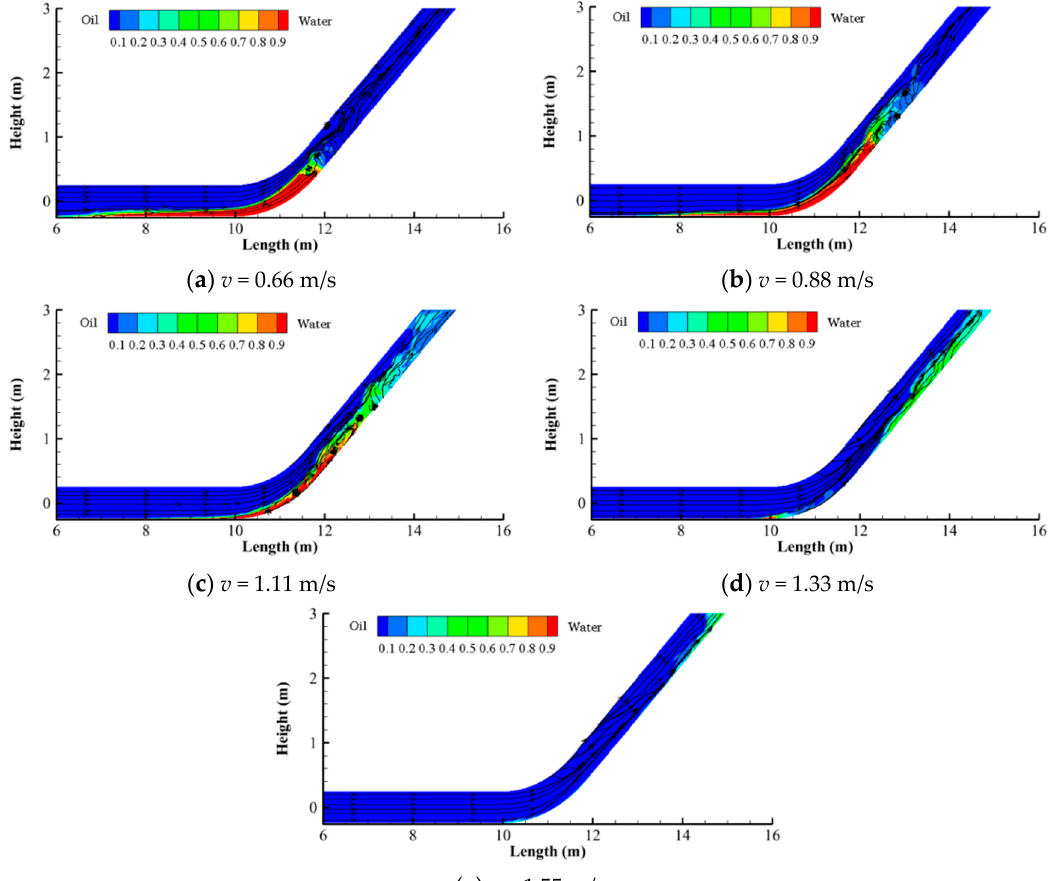
Figure 13. Distribution of oil and water ( α = 40°, t = 11.0 s).